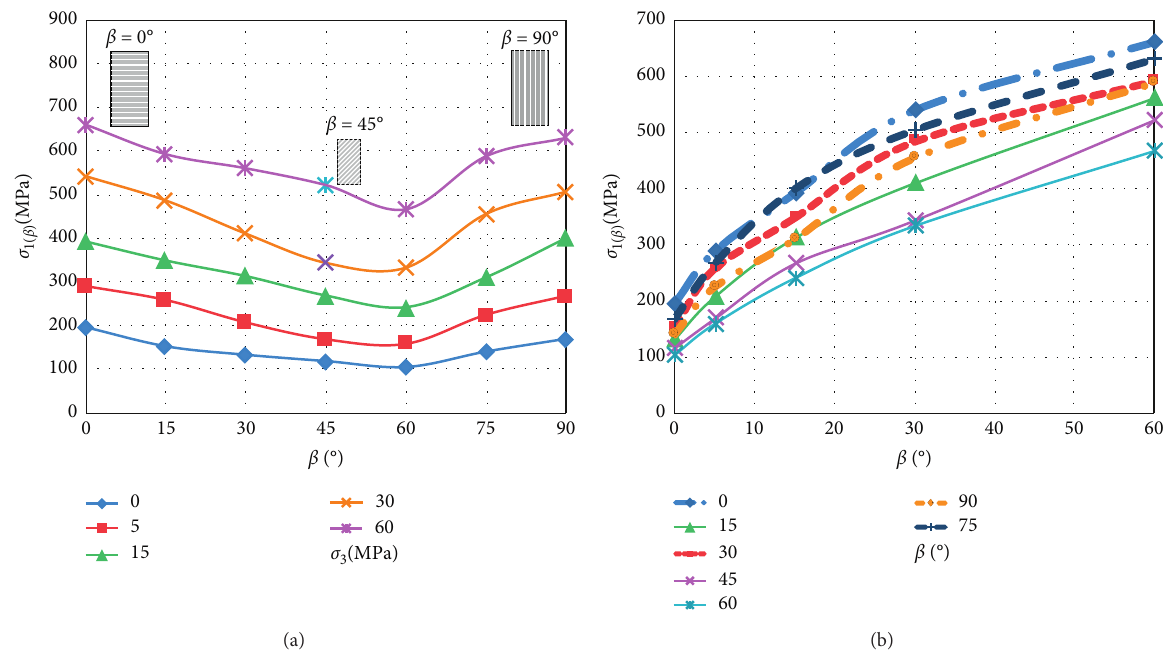
Figure 1: (a) Variation of strength with orientation of bedding. (b) Nonlinear strength behavior (data from